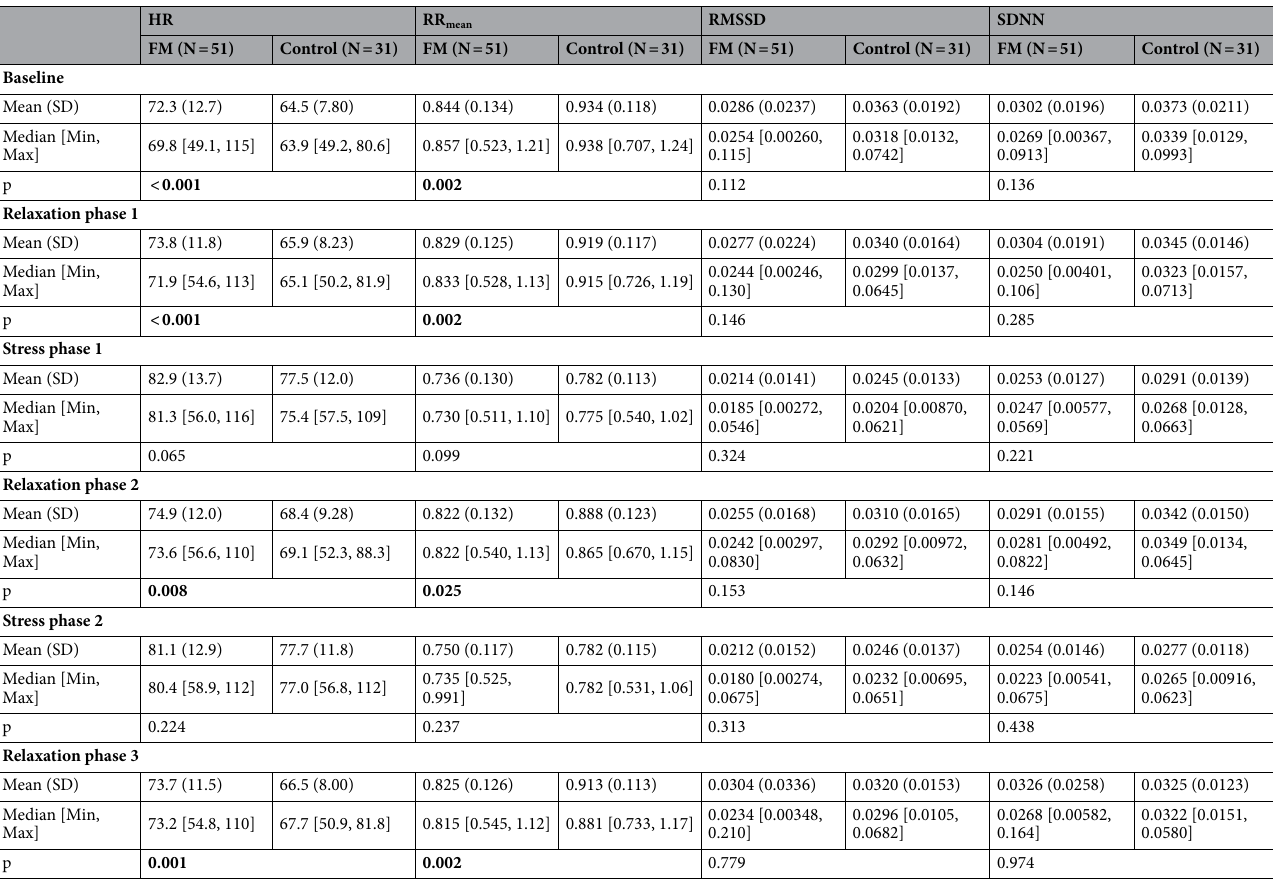
Table 1. Heart rate variability measures: heart rate (HR), mean interval between heart beats (RR mean ), root mean squared interval differences of successive beats (RMSSD), and the standard deviation of intervals between normal heart beats (SDNN). Student’s t-test, p < 0.05. Significant values are in